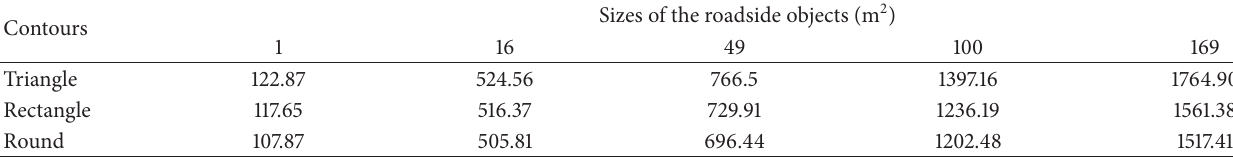
Table 3: The mean legibility distance under 80 km/h.